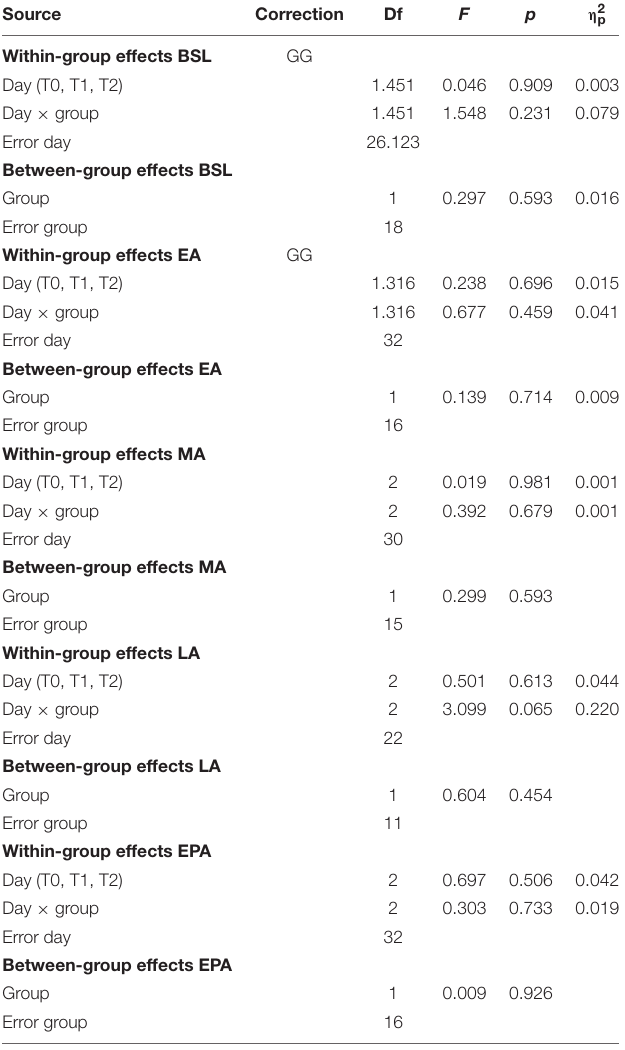
TABLE 2 | Two-way mixed-model ANOVA of gaitline length symmetry across training phases (BSL, late baseline; EA, early adaptation; MA, mid-adaptation; LA, late adaptation; EPA, early postadaptation), with the between-subject factor group (HC vs. PwMS) and the within factor day (T0, T1,